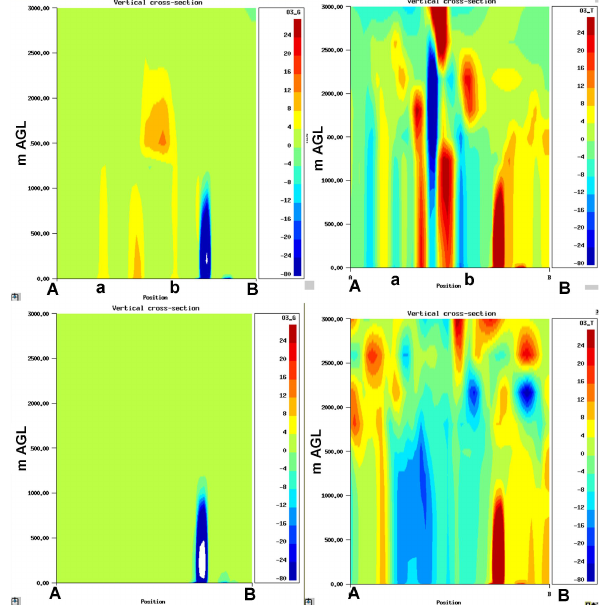
Fig. 9. 18:00 UT (02:00p.m. local time): (a) gas-phase photochem- ical production and loss along cross-section A–B of Fig. 8; (b) total transport rate of change of ozone along cross-section A–B of Fig. 8. (c, d) : as in (a, b), but at 23:00UT (07:00p.m. local